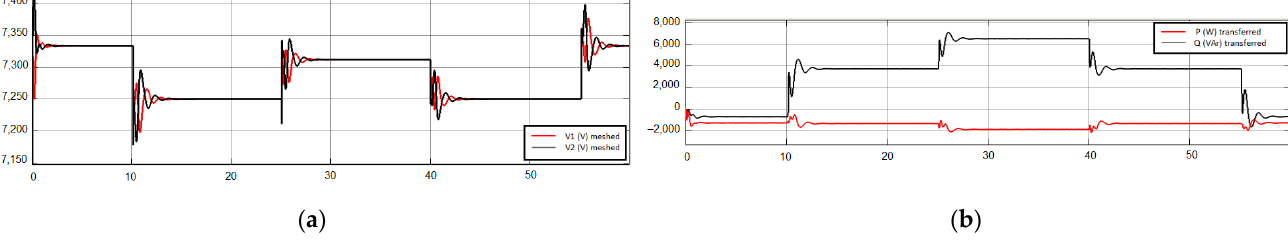
Figure 19. Simulation results of phase-to-ground terminal voltages behavior and the power flow